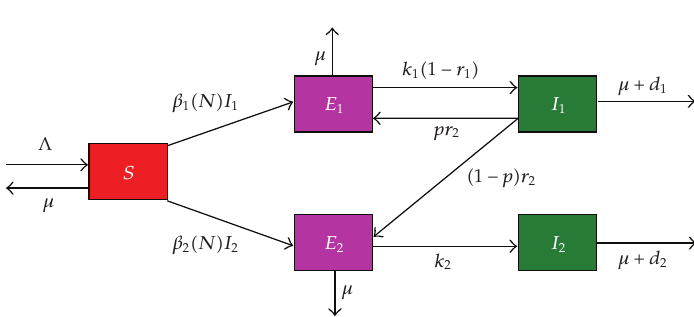
Figure 1: Transfer diagram for the dynamics of tuberculosis with general contact